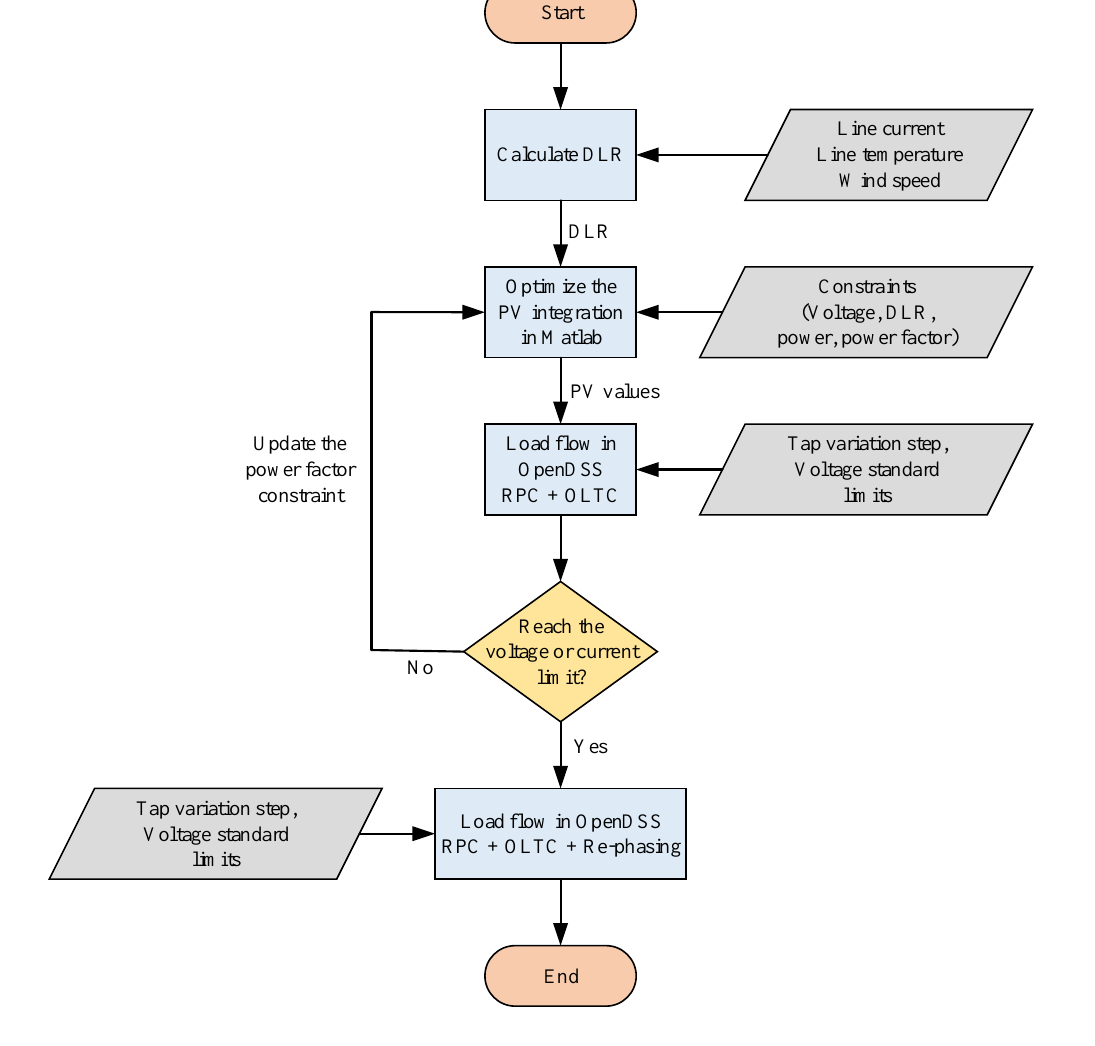
Figure 3. The complete structure of the